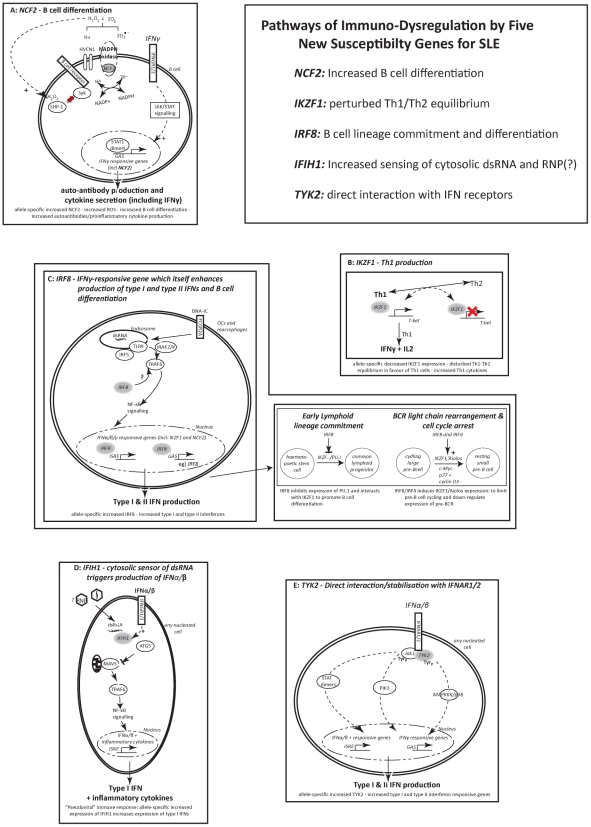
Pathways of immuno-dysregulation by five new susceptibility genes for SLE.The figure shows the interferon-related pathways involving NCF2, IKZF1, IRF8, IFIH1 and TYK2 and and the ways in which these pathways may contribute to lupus susceptibility. In SLE these five genes contribute to increasing the levels of type-I and –II interferons, imbalances in Th1/Th2 related to disease severity, perturbations in B cell physiology and production of a diverse set of auto-antibodies.